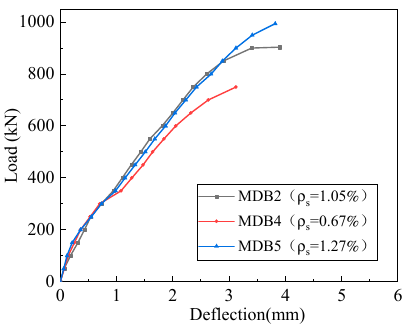
Figure 13. Relation curve between ρ s and deflection.